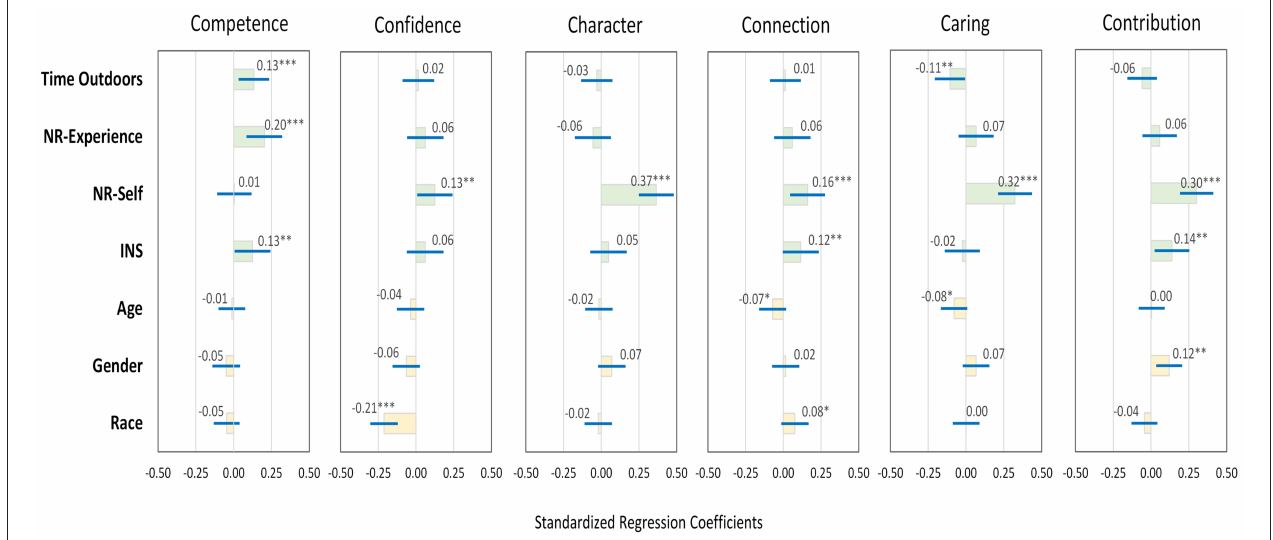
FIGURE 3 | Standardized coefficients ( β , with 95% CI) in OLS regression models examining associations between time in nature (Time Outdoors), connection to nature [Nature-relatedness: Experience, Nature-relatedness: Self, Inclusion of Nature in Self (INS) Scale], and different dimensions of positive youth development (PYD 5 Cs, plus contribution) in a sample of rural middle school students in South Carolina, USA, controlling for demographic variables ( n = 587). * , ** , and *** indicate significance of standardized β at α = 0.10, 0.05, and 0.01,